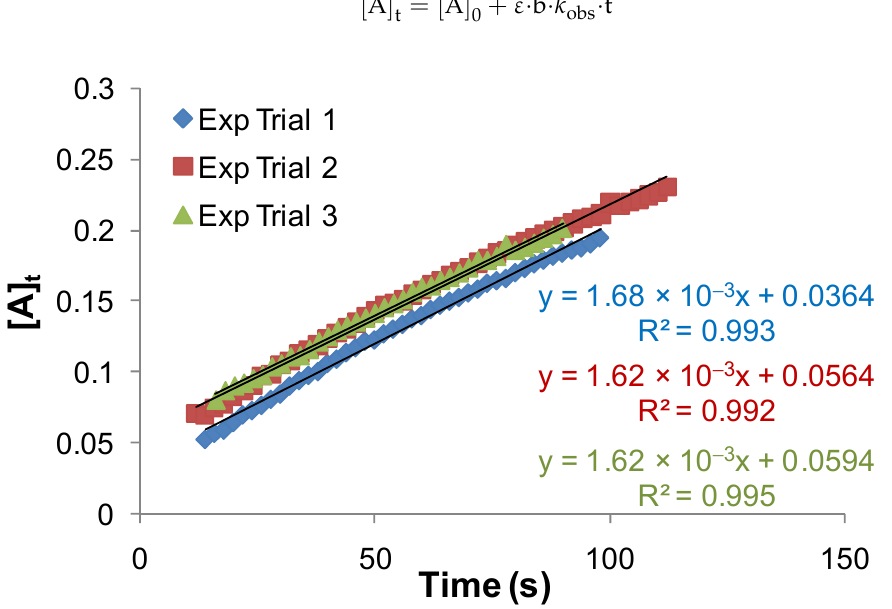
Figure 1. Linear rate equation of integration method for zero-order reaction at 3.2 mM iodide.